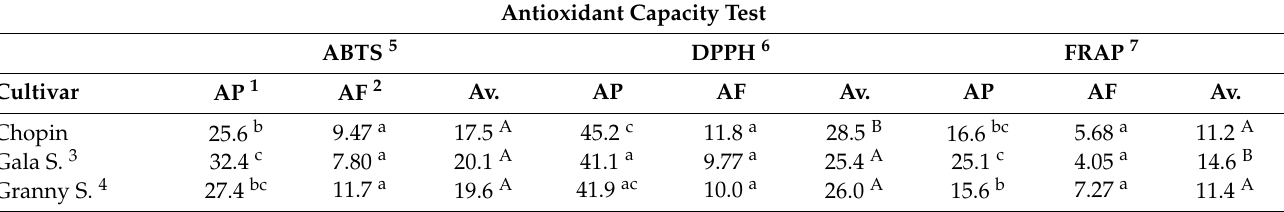
Table 4. Total antioxidant capacity in the apple peel and the apple flesh depending on cultivar (mmol TE kg − 1 FW).